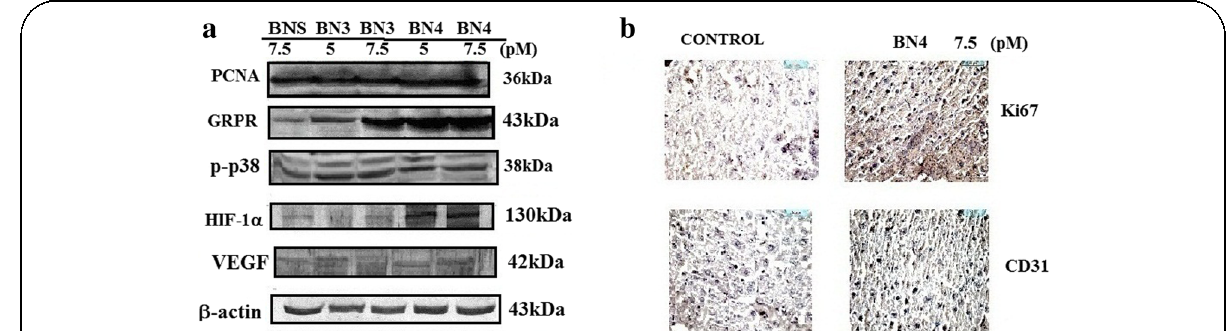
Fig. 8 Western blot analyses of different protein expression such as PCNA, GRPR, p-p38, HIF-1 α , p-53 in MDA-MB-231 cells treated with BNS, BN3, and BN4 at the indicated concentration. β -actin was used as the loading control. a Photomicrographs of immunohistochemical analyses of tumor sections, for expression of Ki-67 (cell proliferation marker) and CD-31 (angiogenesis marker) after BN4 treatment on tumor-bearing mice. b Results are representative of three independent experiments. The level of protein expression was found to increase gradually in a dose-dependent